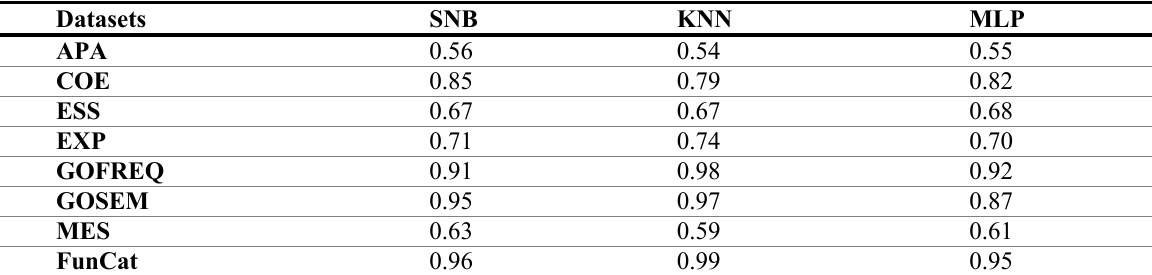
Table 2. The predictive AUC values obtained by each machine and statistical learning method using individual datasets.